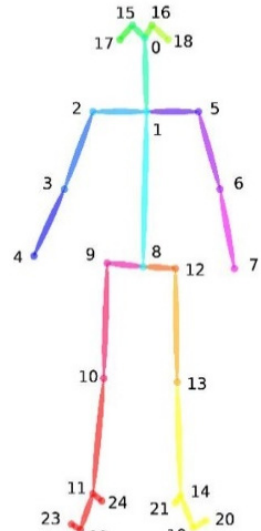
Figure 6. OpenPose Body-25 configuration of the human skeleton.